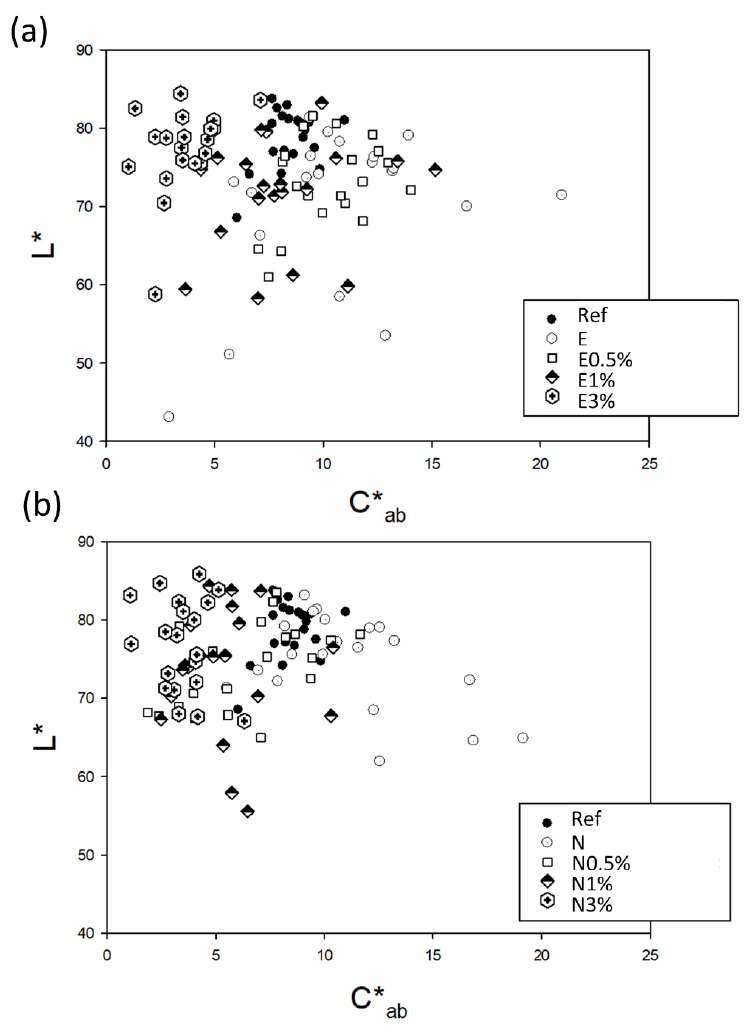
Figure 4. L* and C* ab —scatter plots of the surfaces treated with the two consolidants and di ff erent nanoparticles TiO 2 concentrations. Measurements for the reference uncoated granite (Ref) and the coated surface only with the consolidant are also shown. ( a ) Estel 1000 samples; ( b ) Nano Estel samples. Check Table 1 to understand the acronyms.